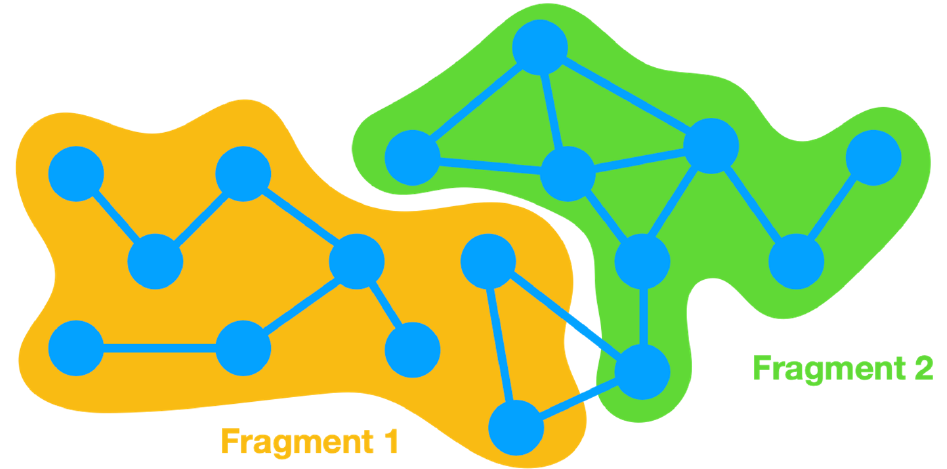
Figure 2. Example of a hypothetical molecular system split into two fragments. The circles and lines represent atoms and covalent bonds, respectively.